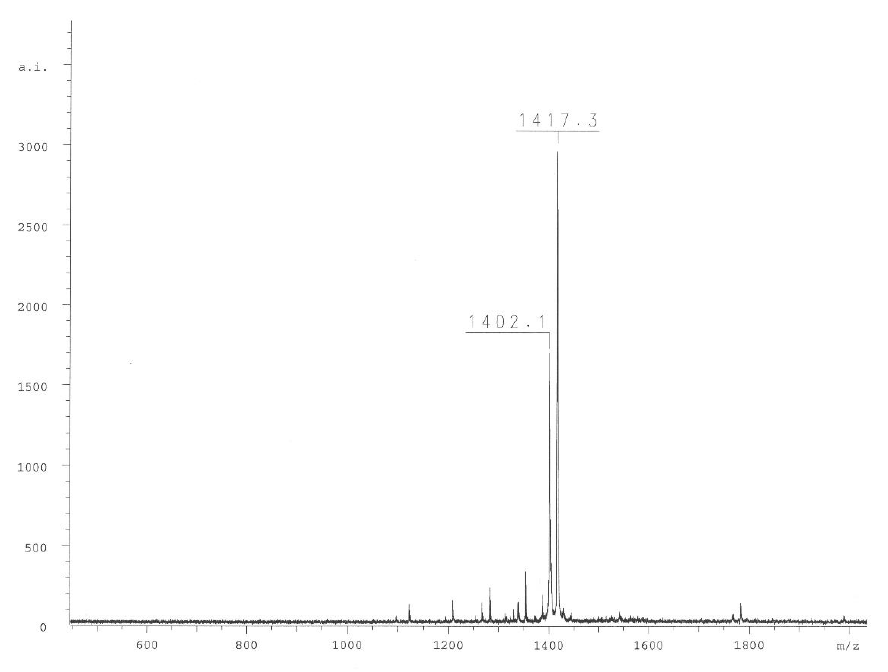
Figure 4. Mass spectrometry analysis of substrate 1 .